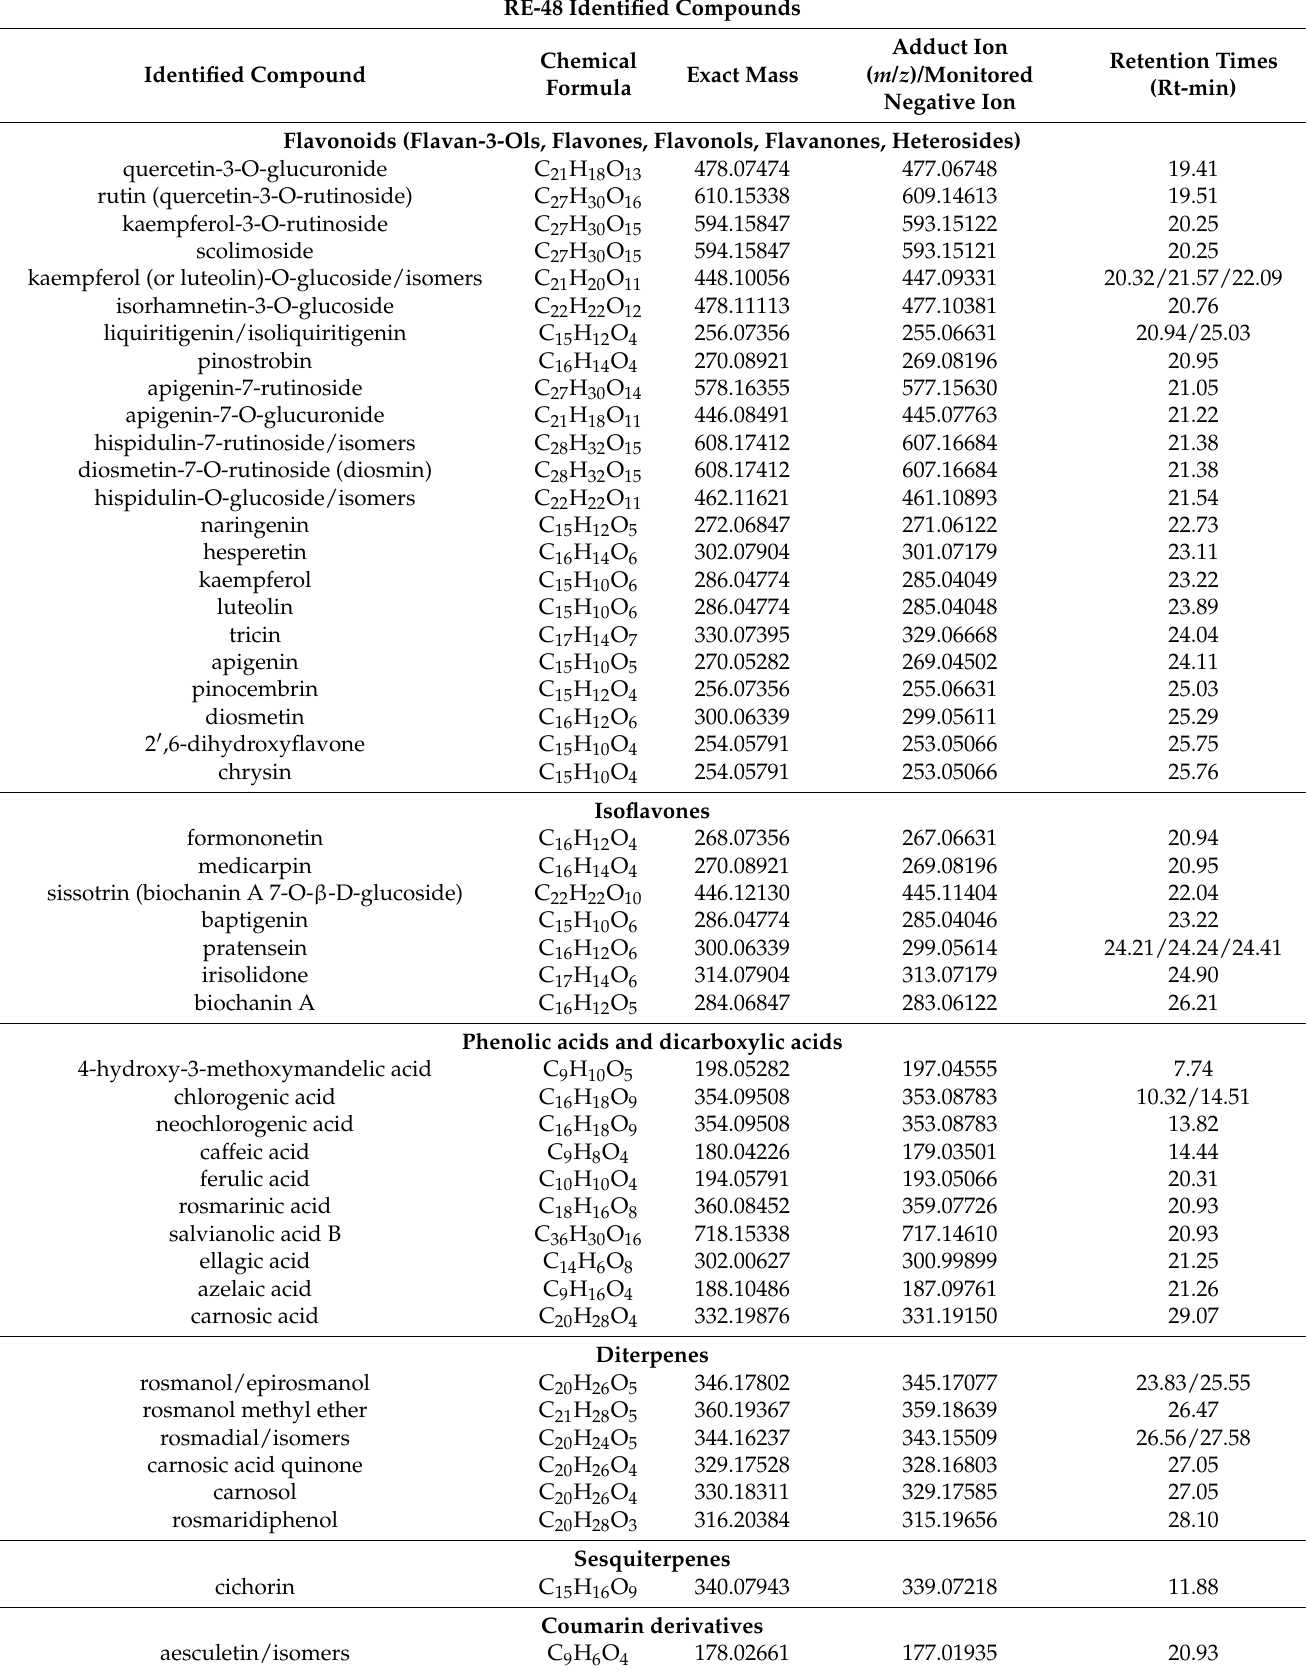
Table 3. Chemical compounds identified in RE by